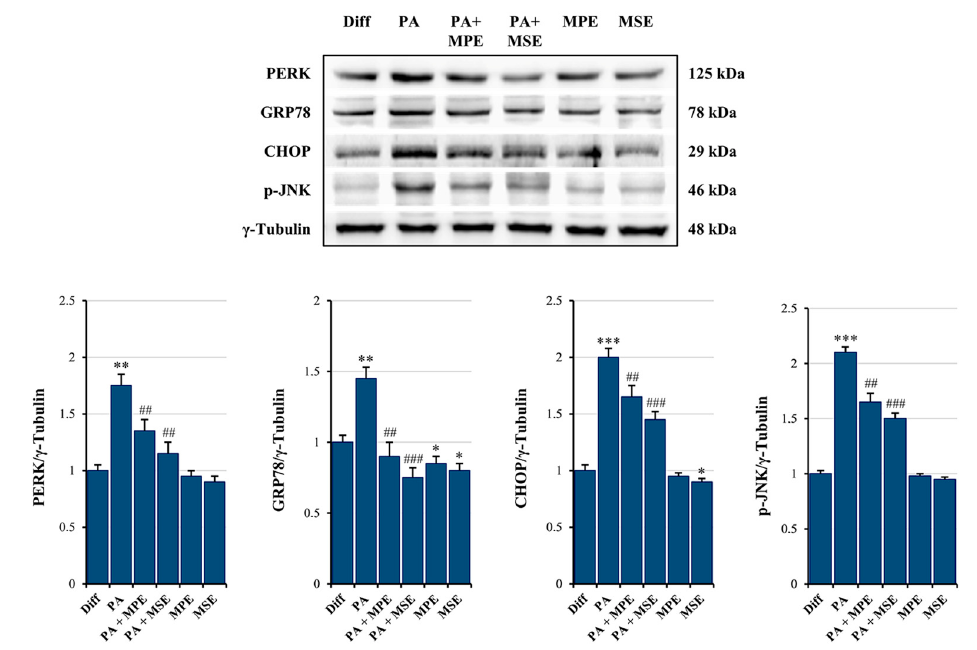
Figure 5. MPE and MSE reduce PA-induced ER stress in 3T3-L1 adipocytes. Differentiated 3T3-L1 adipocytes were treated with 500 µM PA for 48 h in the presence or absence of 100 µg/mL MPE or MSE. Cell lysates underwent Western blotting analysis for ER stress protein markers PERK, GRP78 and CHOP, as well as for phosphorylated JNK (p-JNK). Equal loading of protein (30 µg) was verified by immunoblotting for γ -Tubulin. The bar graphs represent the means of three independent experiments ± SD. The statistical differences between groups were evaluated using a one-way ANOVA test. * p < 0.05, ** p < 0.01 and *** p < 0.001 were significant with respect to differentiated 3T3-L1 adipocytes. ## p < 0.01, ### p < 0.001 were significant with respect to PA-treated differentiated 3T3-L1 adipocytes.